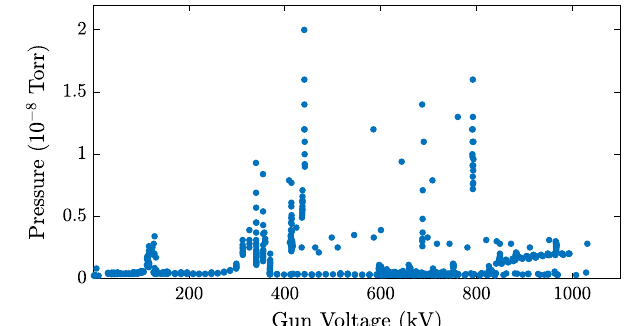
FIG. 13. Areas of the gun affected by multipacting (shown in white). Primary electrons are emitted from the surface of the FPC. FIG. 14. Pressure in the FPC during